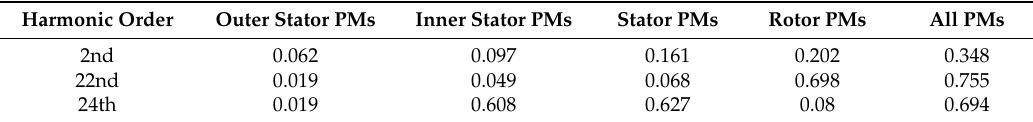
Figure 10. Inner air gap flux density with different excitation sources and corresponding harmonic spectra. ( a ) Flux density wavefroms; ( b ) corresponding harmonic spectra. Table 5. Main inner airgap flux density harmonics amplitude (T).